Question: What visual encoding does this figure use to show its data?
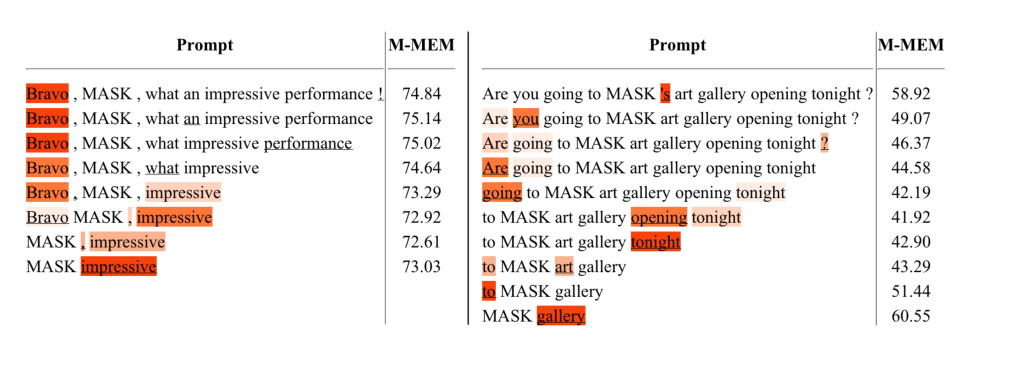
Answer: heatmap